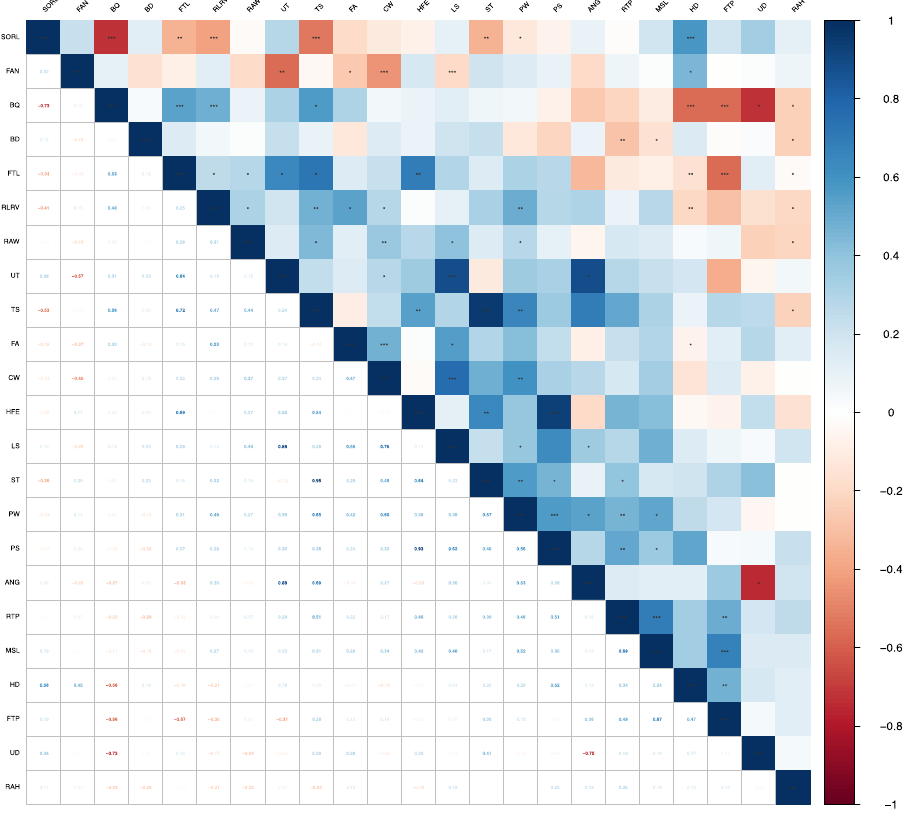
Figure 1. Genetic correlations between conformation traits in Chinese Holsteins. The upper triangle is the result of the significance test, and the lower triangle is the Pearson correlation coefficient. Blue represents a positive correlation and red represents a negative correlation. * : significant level less than 0.05, ** : significant level less than 0.01, *** : significant level less than 0.001. The genetic correlations among frame capacity traits ranged from 0.15 to 0.76. The genetic correlation between BD and CW was low (0.15), but the genetic correlation be- tween CW and LS was large and positive (0.76), indicating a moderately positive genetic correlation. The phenotypic correlations among frame capacity traits ranged from 0.13 (BD and LS) to 0.24 (ST and BD, ST and CW), and all the phenotypic correlations were moderate to weak in magnitude. Both genetic and phenotypic correlations were positive between PS and PW, but the phenotypic correlation was small (0.08).